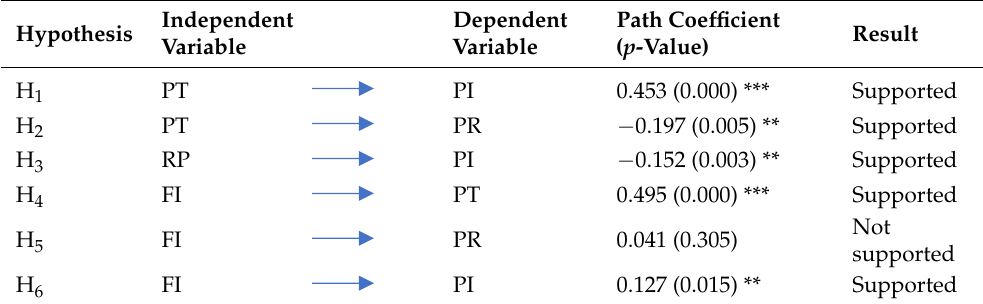
Table 4. Structural model. Path coefficients and hypotheses results.